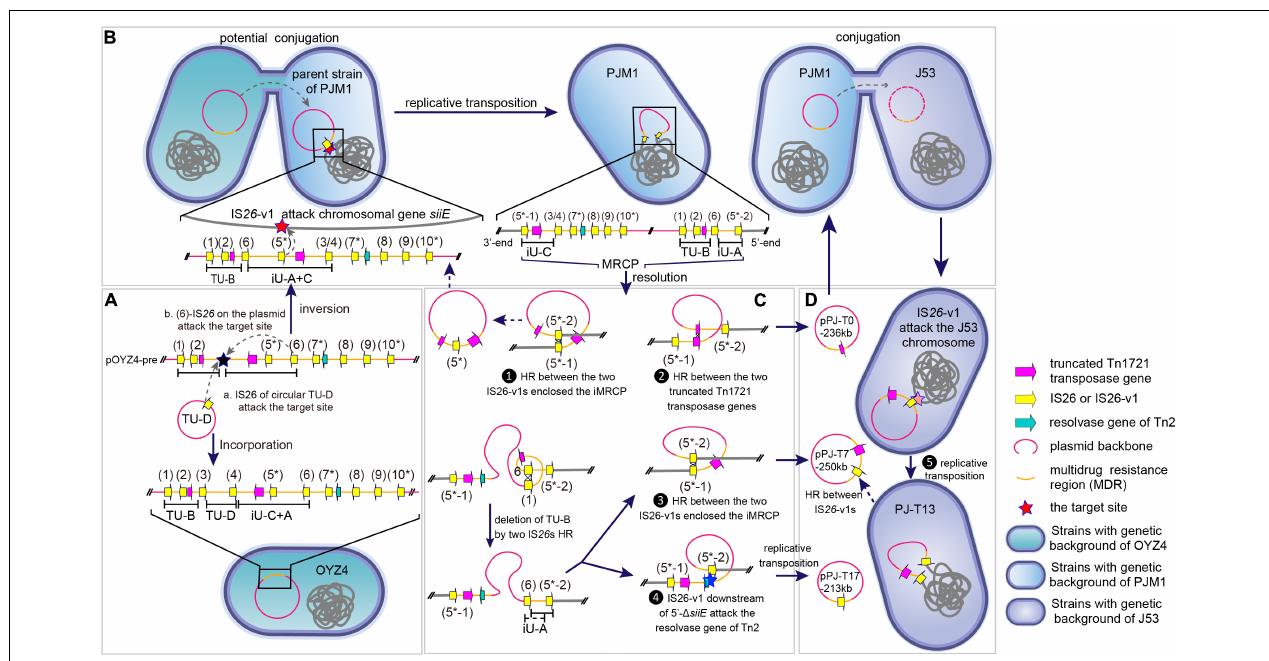
FIGURE 4 | Presumptive formation and multiple transmission form of MRCP. (A) a. TU-D was inserted into the precursor plasmid pOYZ4-pre via conservative transposition, forming pOYZ4. b. The IS 26 copy 6 in pOYZ4-pre attacked the target site (black star) in the opposite DNA strand, causing reversal of iU-C + A segment. (B) IS 26-v1 in iU-A + C segment attacked the chromosomal siiE of PJM1 during conjugation, forming the cointegrate by intermolecular replicative transposition. The plasmid in PJM1 chromosome was renamed MRCP according to its characteristics. (C) Diverse resolution of MRCP. (cid:182) The direct homologous recombination between IS 26-v1 copies 5*-1 and 5*-2 mediated the generation of a plasmid identical to pPOYZ4-pre except for reversed iU-C + A. (cid:183) The direct homologous recombination between two truncated Tn 1721 led to plasmid pPJ-T0-236kb. (cid:184) Deletion of TU-B and homologous recombination between IS 26-v1 copies 5*-1 and 5*-2 yielded plasmid pPJ-T7-250kb or pPJ-T16-250kb. (cid:185) Intramolecular replicative transposition resulted in the formation of plasmid pPJ-T17-213kb. After TU-B being deleted by homologous recombination, IS 26-v1 copy 5*-2 attacked the target site (blue star) in the resolvase gene of Tn 2 , forming plasmid pPJ-T17-213kb. (D) (cid:186) Intermolecular replicative transposition led to PJ-T13-chr250kb. When a plasmid such as pPJ-T7-250kb was transferred into E. coli J53 by conjugation, IS 26-v1 copy 5 attacked J53 chromosome, and PJ-T13-chr250kb in PJ-T13 was